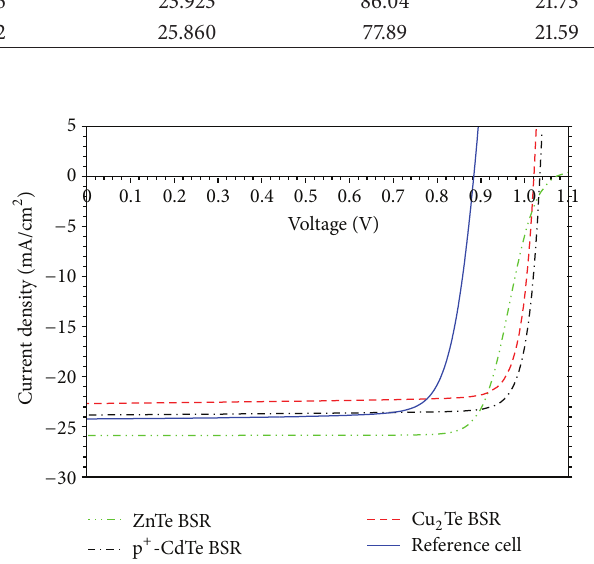
Figure 5: 𝐼 - 𝑉 curve of reference cell and modified